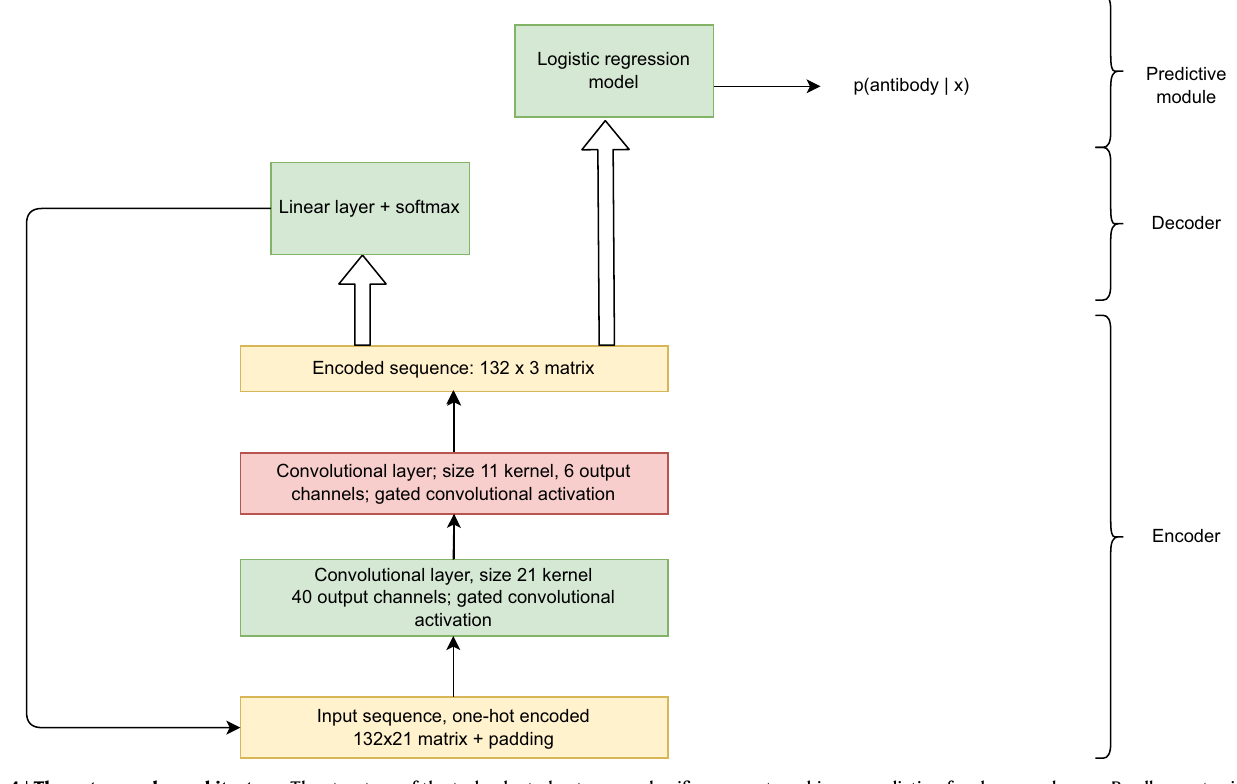
classi fi er generates a binary prediction for decoy vs. human B-cell receptor in its training set.